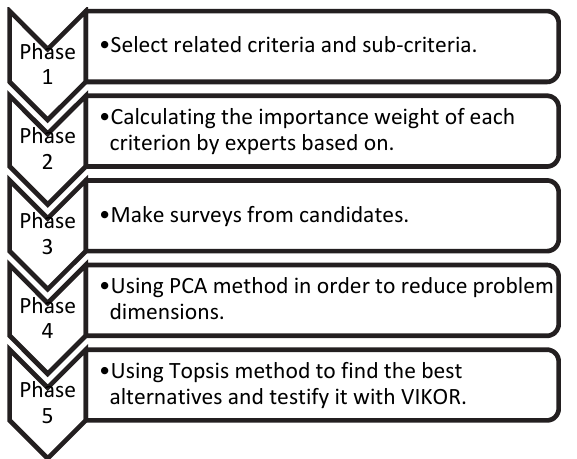
Fig. 3 . Algorithm of project manager